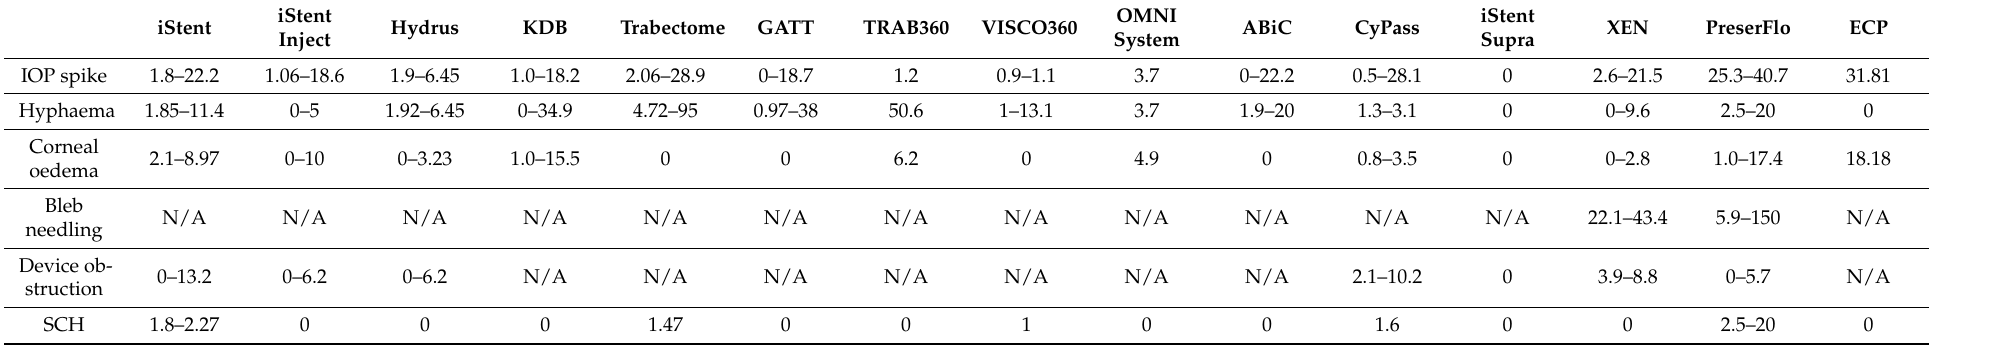
Table 1. Summary of Principal Complications (%) by Device